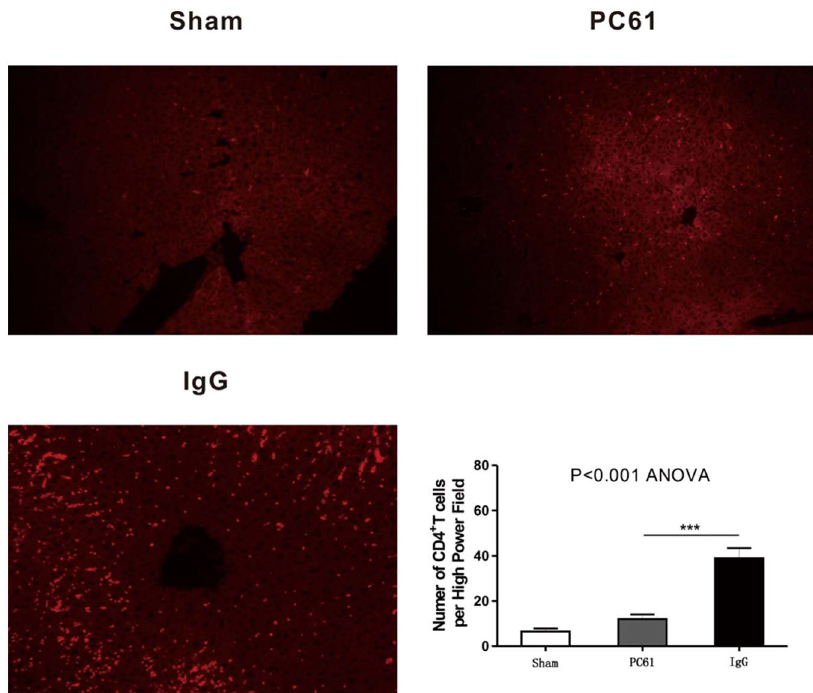
Figure 5. Anti-CD25 mAb pretreatment decreased CD4 + T cells proliferation and deposition. Immunofluorescence analyses of Sham, PC61, and IgG livers one hour following sham or partial hepatic ischemia-reperfusion surgeries. CD4 was stained red and the number of CD4 + T cells per High Power Field was figured up and quantitative analyzed.